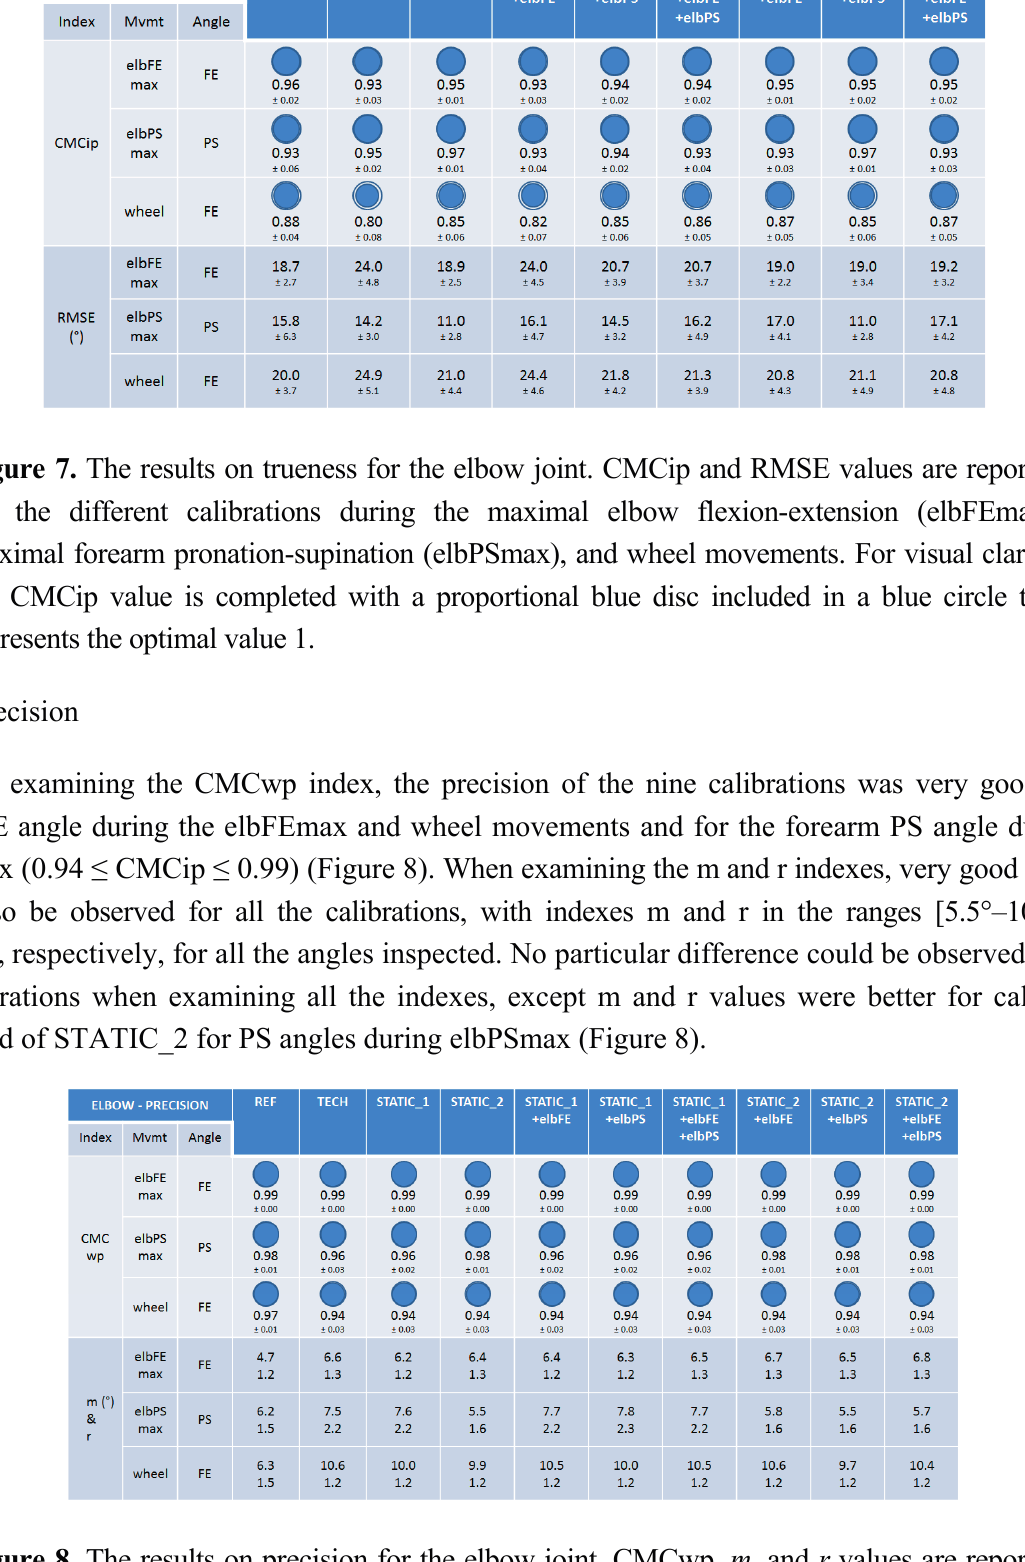
Figure 8. The results on precision for the elbow joint. CMCwp, m , and r values are reported for the different calibrations and the REF method during the maximal elbow flexion-extension (elbFEmax), maximal forearm pronation-supination (elbPSmax), and wheel movements. For visual clarity, the CMCwp value is completed with a proportional blue disc included in a blue circle that represents the optimal value